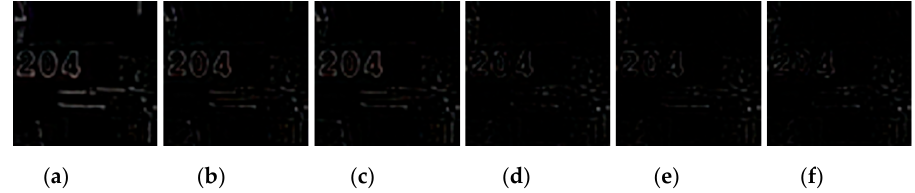
Figure 16. Di ff erence images between the region marked with the green box in Figure 15a and its Figure 16. Difference images between the region marked with the green box in Figure 15a and its Figure 16. Difference images between the region marked with the green box in Figure 15a and its Figure 16. Difference images between the region marked with the green box in Figure 15a and its deblurred results. ( a ) ECP; ( b ) EPLL; ( c ) NCSR; ( d ) SRN; ( e ) DPDNN; ( f ) proposed deblurred results. ( a ) ECP; ( b ) EPLL; ( c ) NCSR; ( d ) SRN; ( e ) DPDNN; ( f ) proposed method. deblurred results. ( a ) ECP; ( b ) EPLL; ( c ) NCSR; ( d ) SRN; ( e ) DPDNN; ( f ) proposed method.